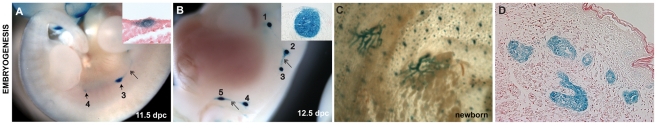

PTHrP expression during embryogenesis.LacZ staining of PTHrP+/
lacZ embryos at (A) E11, (B) E12, (C) E15.5 and (D) birth. (A) At E11, β-galactosidase staining was observed in the mammary placodes but not the surrounding mesenchyme. (B) By E12.5, intense staining was observed in all five buds. Interestingly, lacZ positive “tails” were observed from each bud (double arrowhead) (B, C). Single arrowheads indicate mammary placodes and buds. (D) PTHrPlacZ expression remains restricted to the mammary epithelial cells throughout embryonic and neonatal development.